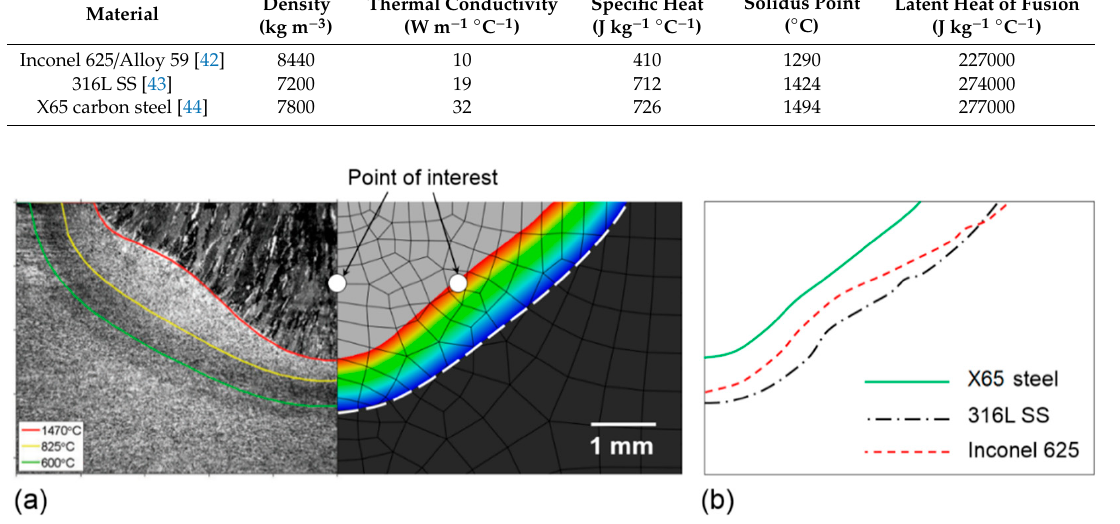
Figure 6. ( a ) Simulated weld of X65 carbon steel, and ( b ) fusion line geometries for different materials.